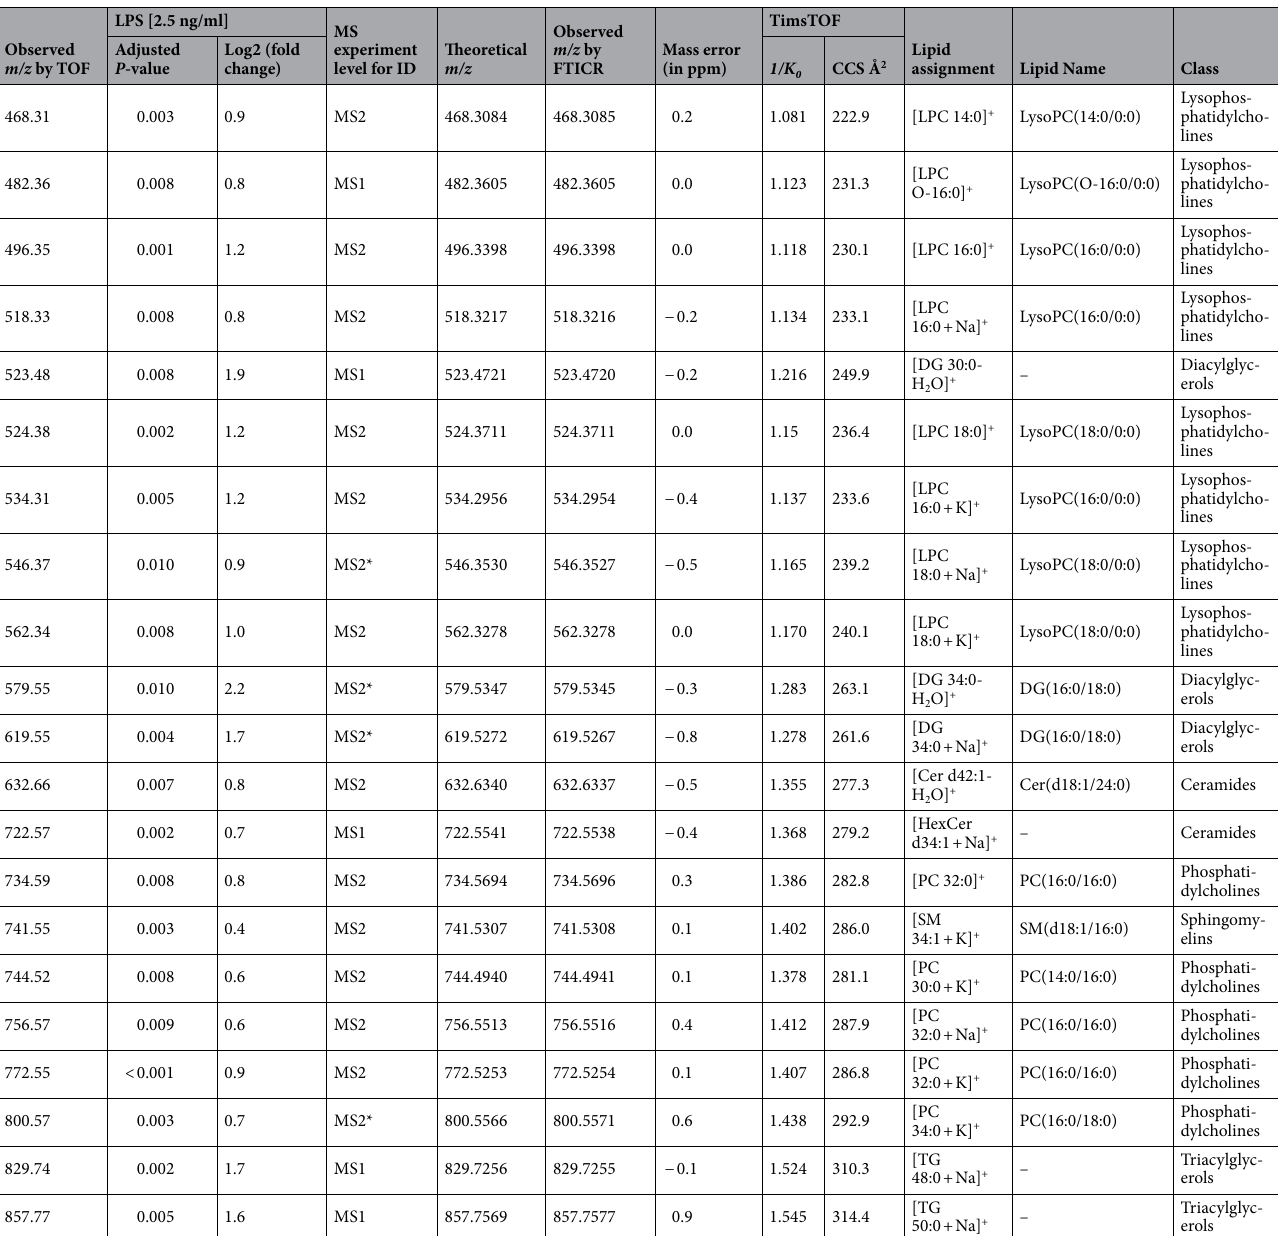
Table 1. Differential lipids in LPS-treated SIM-A9 microglial cells identified using MALDI MS-based cell fingerprinting. Based on volcano plots and the Venn diagram in Fig. 3d, we narrowed 29 m /z features (= candidate signals) increased in the LPS-treated groups down to 21 identified molecules that overlapped in all LPS groups (Welch’s T-Test and Benjamini and Hochberg adjusted P value threshold ≤ 0.01 for positive ion mode). High resolution MS (MS1) and tandem MS (MS2) were used for assignments of candidate marker lipids. Note that, here, positional distribution of the fatty acids esterified to the glycerol backbone of the phospholipid were not determined. *MS/MS confirmation in TimsTOF fleX